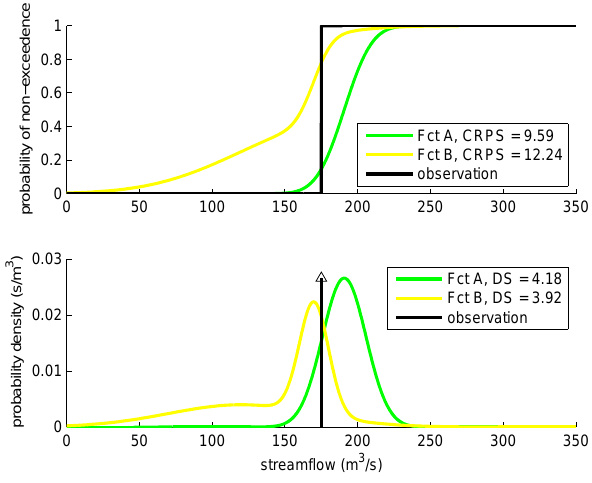
Fig. 2. The RPS and CRPS scores measure the sum of squared differences in CDFs. Therefore they depend on probabilities assigned to events that where not observed. The divergence score only depends on the value of the PDF (the slope of the CDF) at the value of the observation. In the example, forecast A has a better (=lower) CRPS than forecast B, even though it assigned a lower probability to what was observed (resulting in a higher (=worse)